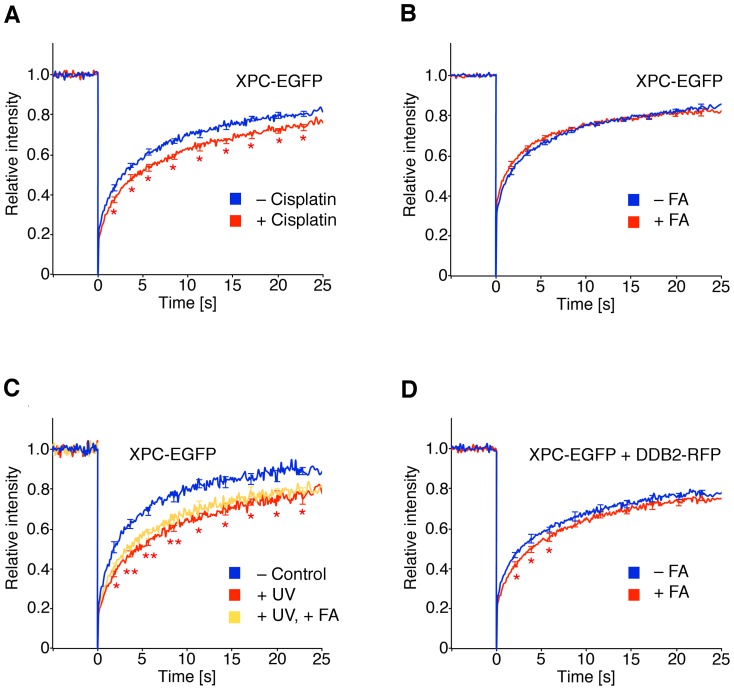
Indirect formaldehyde-induced reduction of XPC mobility.(A) Protein dynamics studies of XPC in the nuclei of human fibroblasts. Cells were transfected with the XPC-EGFP construct, incubated with 5 μM cisplatin and subjected to FRAP analysis (N = 30; error bars, S.E.M.). The resulting fluorescence recovery curves were compared to those of untreated controls (*p<0.05). (B) FRAP studies (N = 50) demonstrating that the fluorescence recovery curves of XPC-EGFP are not affected by an 18-h formaldehyde treatment (75 μM). (C) FRAP analysis of transfected fibroblasts demonstrating that the 18-h formaldehyde treatment (75 μM) does not further reduce the delayed XPC-EGFP trafficking in UV-irradiated cells (30 J/m2; N = 50). (D) Combined formaldehyde treatment and DDB2 overexpression. The transfected fibroblasts were exposed to 75 μM formaldehyde for 18 h and subjected to FRAP analysis. The presence of DDB2-RFP resulted in a slightly delayed fluorescence recovery curve of XPC-EGFP upon formaldehyde exposure (N = 30). Asterisks, significant differences between formaldehyde-treated and untreated fibroblasts (*p<0.05).